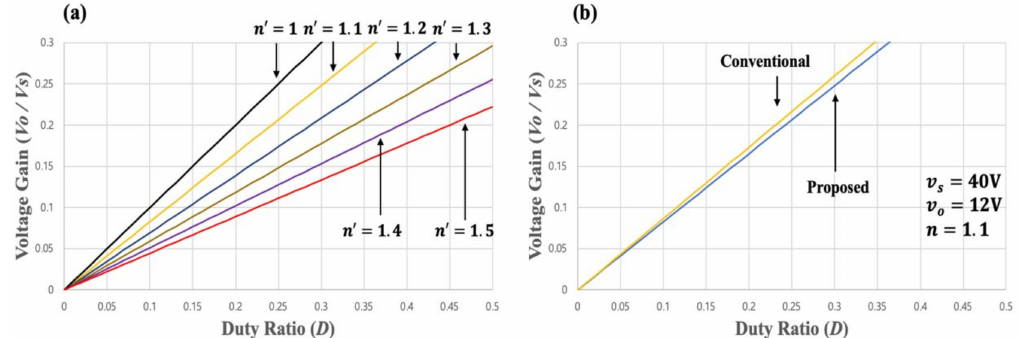
Figure 10. ( a ) Relationship curve between duty ratio D and voltage gain v o / v s for different values of turns ratio n ; ( b ) Comparison curve between the conventional CDR and the proposed